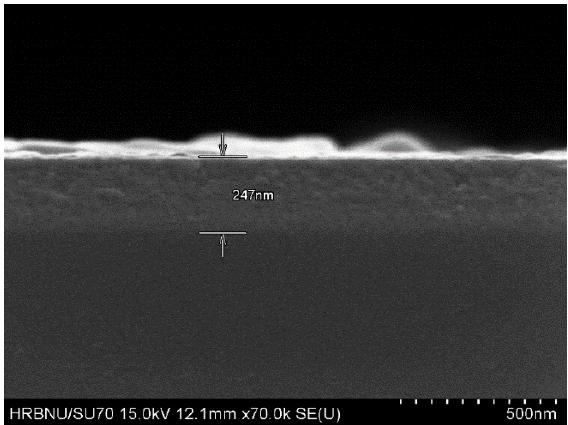
Figure 4. Cross section scanning of the Ga 2 O 3.